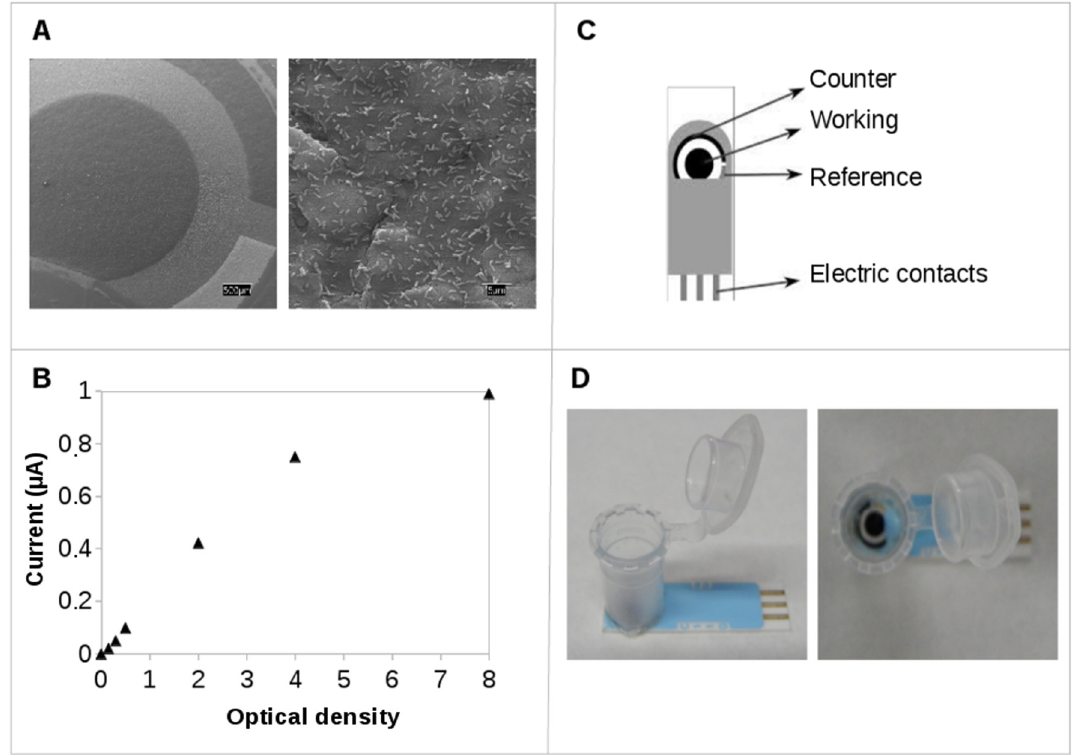
Figure 1. ( A ) Scanning electron microscopy (SEM) image of G. sulfurreducens attached to a carbon screen ‐ printed electrode (SPE); ( B ) steady current production of G. sufurreducens at different cell density; ( C ) scheme of a SPE; and ( D ) detail of a lid ‐ tube sealed to the SPE ceramic